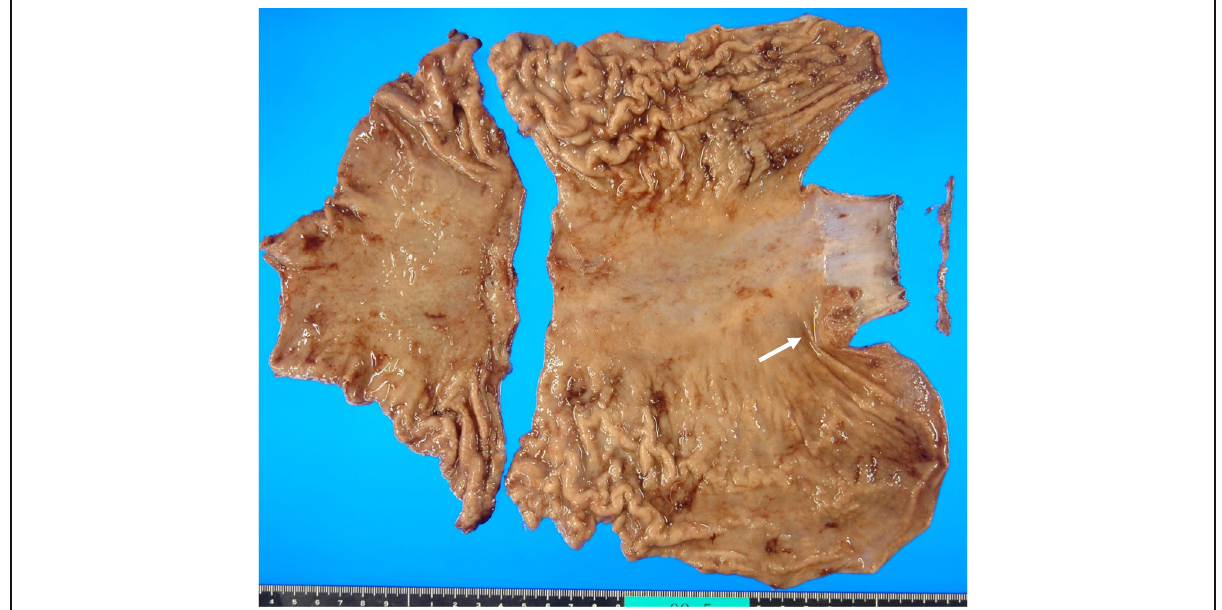
Fig. 2 Macroscopic findings of the resected stomach. The tumor size was 25 × 17 mm